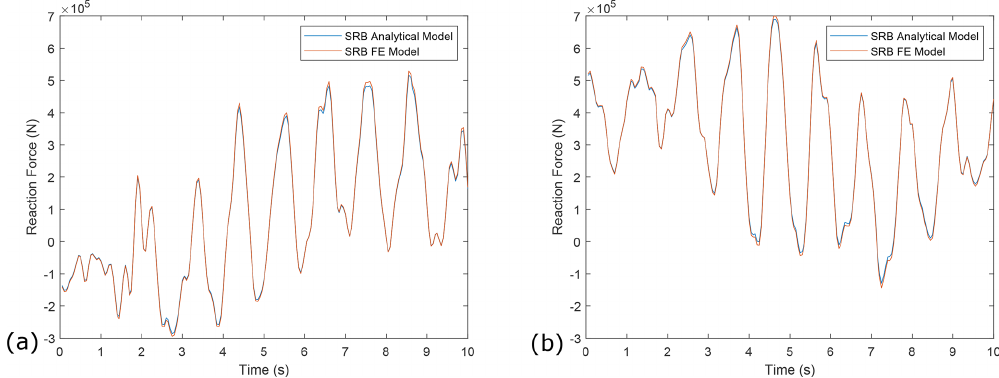
Figure 6. (a) Example time series of reaction force results in the horizontal plane from the analytical and DSRB FE models. (b) Example time series of reaction force results in the vertical plane from analytical and DSRB FE models.